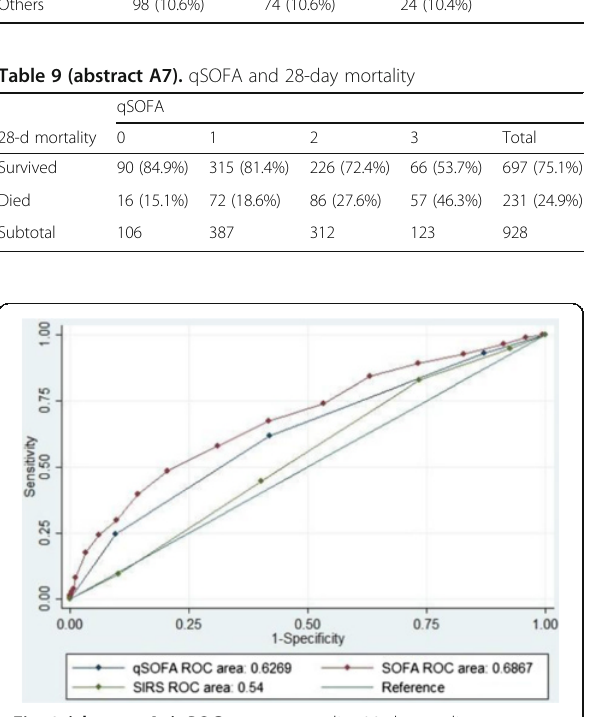
Fig. 3 (abstract A7). ROC curve to predict 28-d